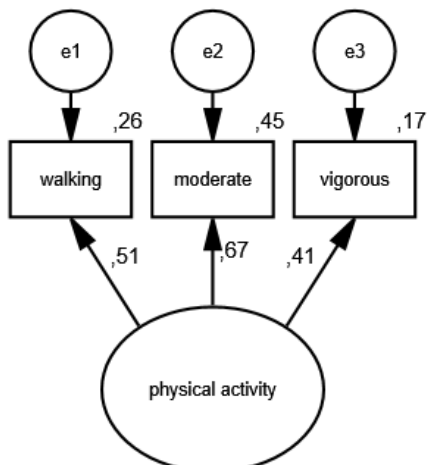
Figure 1. Standardized effects of the model of physical activity measurement in the group of women .